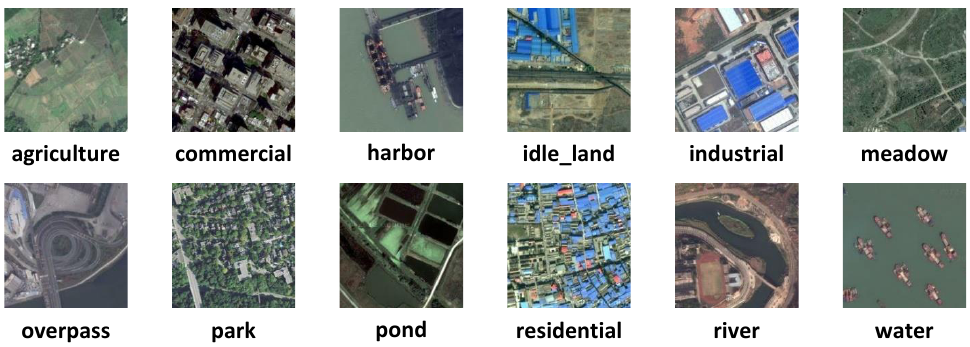
Figure 8. Examples of different categories in the SIRI-WHU